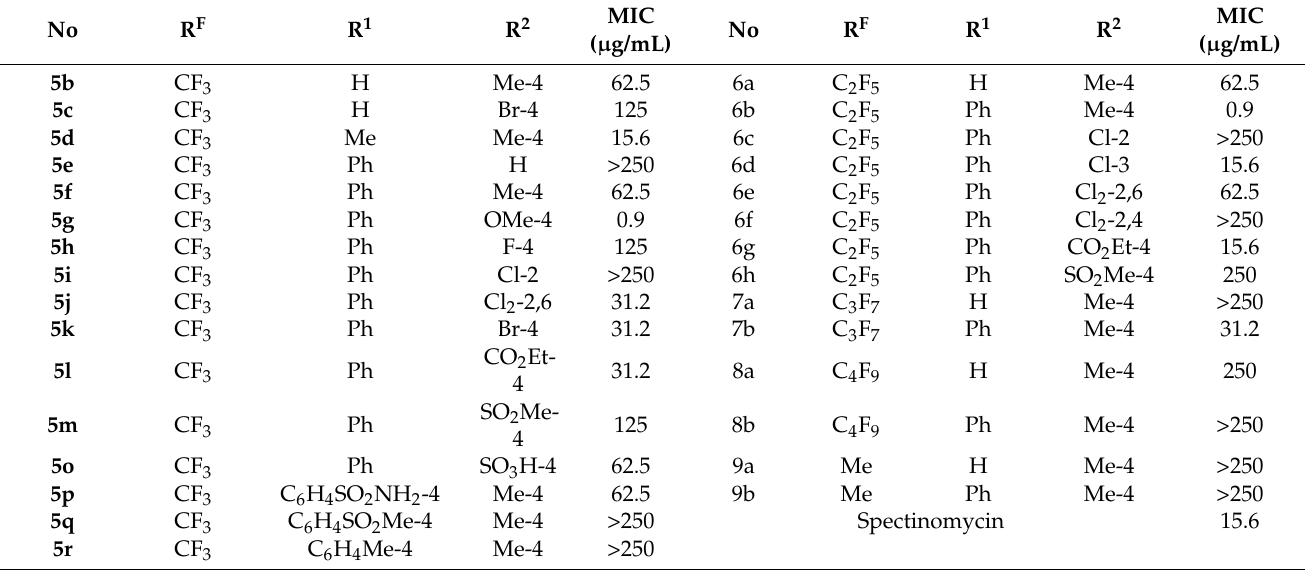
Table 6. Antibacterial activity of 4-AHPs 5–9 against Neisseria gonorrhoeae